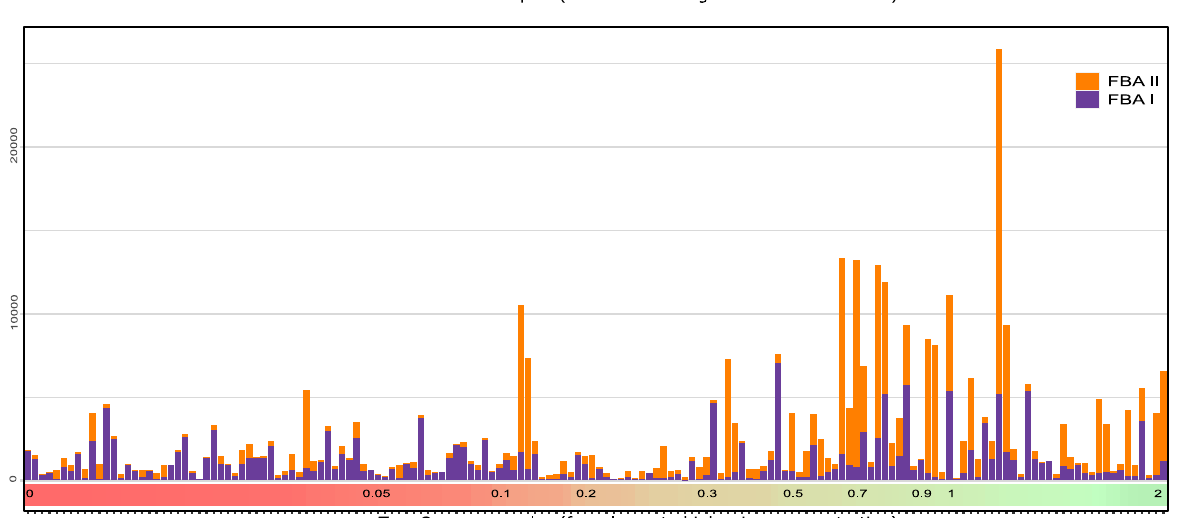
Fig. 4 Expression of iron-related genes in P. calceolata . a Relative gene expression levels normalized in transcript per million (TPM) of fi ve phytotransferrins ( ISIP2A ) and two putative iron storage ( ISIP3 ) in low-iron (<0.2 nM) and high-iron (>0.2 nM) oceanic stations. P values of Wilcoxon statistical tests between low- and high-iron conditions are indicated for each gene. Signi fi cant P values (<0.01) are in bold. b Relative expression levels (TPM) of genes coding for ferredoxin (orange) and its non-ferrous equivalent fl avodoxin (purple) in each Tara Oceans sample. Samples are sorted from low-iron (left) to high-iron (right) conditions. Iron concentrations are indicated in nM on the colored horizontal bar. c Same representation for genes coding for fructose-bisphosphate aldolase II (orange) and its non-ferrous equivalent fructose-bisphosphate aldolase I